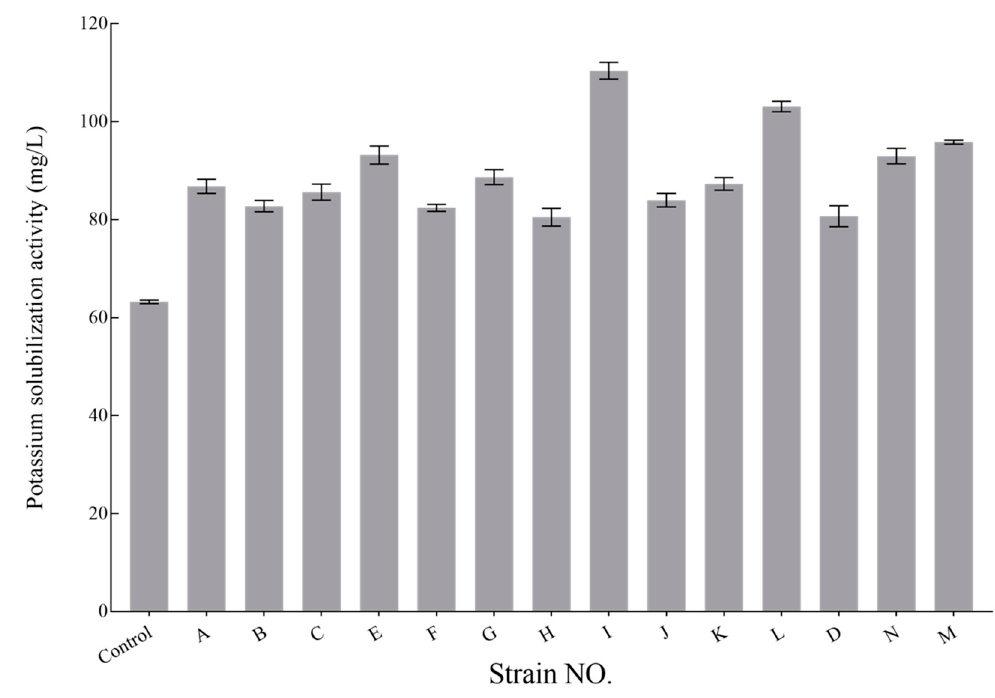
Figure 4. Potassium-solubilizing activity of KSB isolates in aqueous medium. Each bar represents a mean ( ± standard deviation) value of soluble K content in mg L − 1 . Uninoculated solution was used as a control (first bar). The black lines on the column chart are the marks of the standard error (SE) for three samples from three replications. ( p < 0.05).